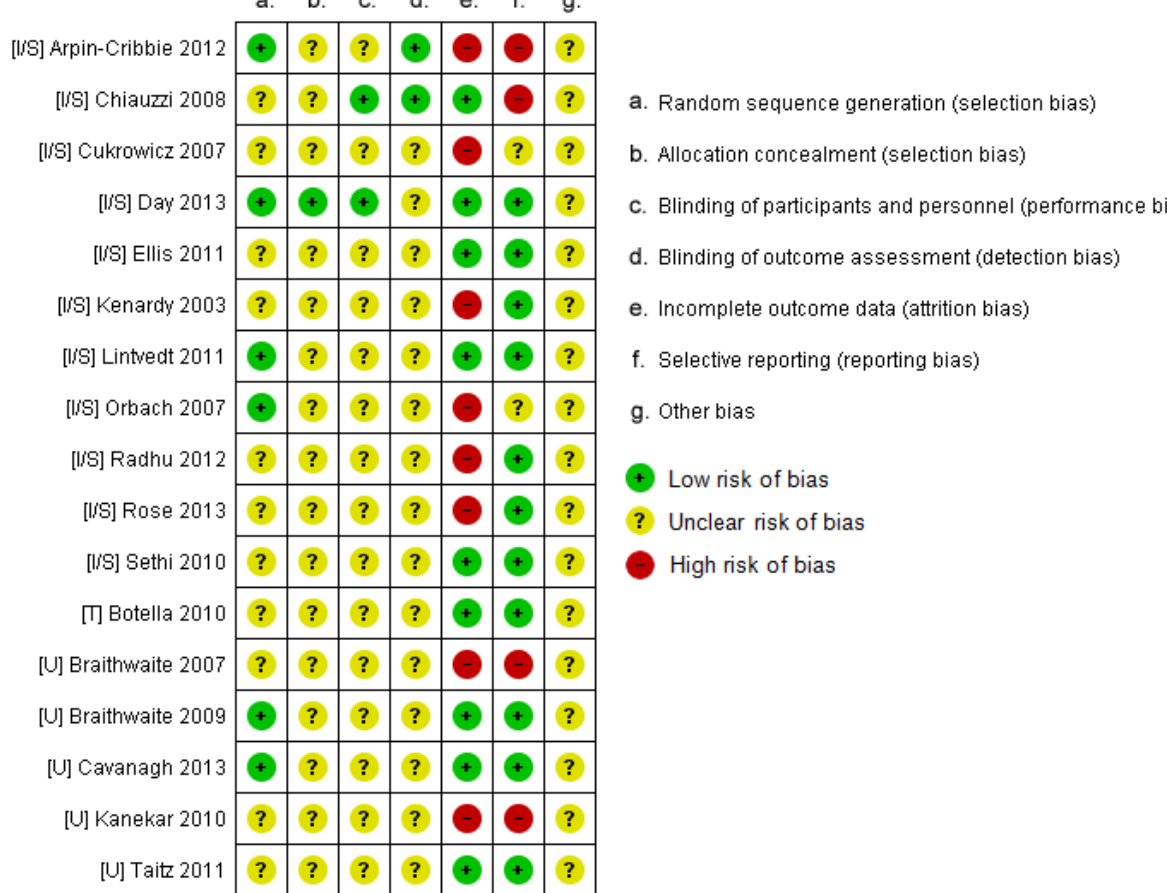
Figure 2. Breakdown of each type of risk of bias identified in the included